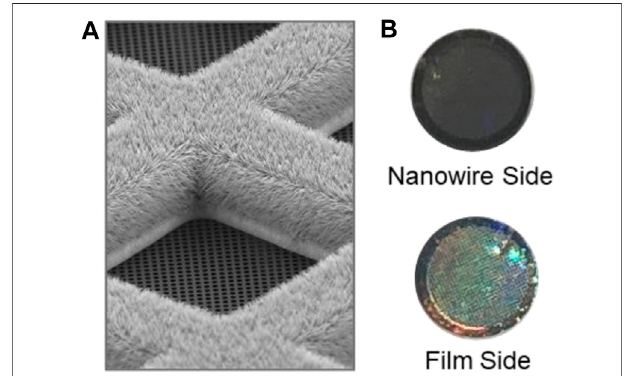
FIGURE 3| Self-wicking nanowire grids. (A) . SEM image showing a grid bar junction with the nanowire side of the grid facing up, with the 1.2 μ m diameter holes, 0.8 μ m edge-to-edge spacing holey carbon fi lm facing down. (B) . The nanowire side of the grid should face towards the dispenser in the chameleon system (to the right). The nanowire side of the grid is characterised by a darker, copper colour, whereas the fi lm side of the grid is characterised by a silver-coloured rim and a more obvious rainbow appearance of the fi lm.